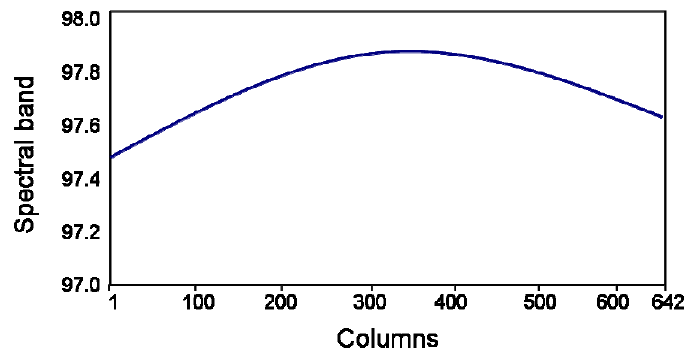
Figure 6. Position of oxygen